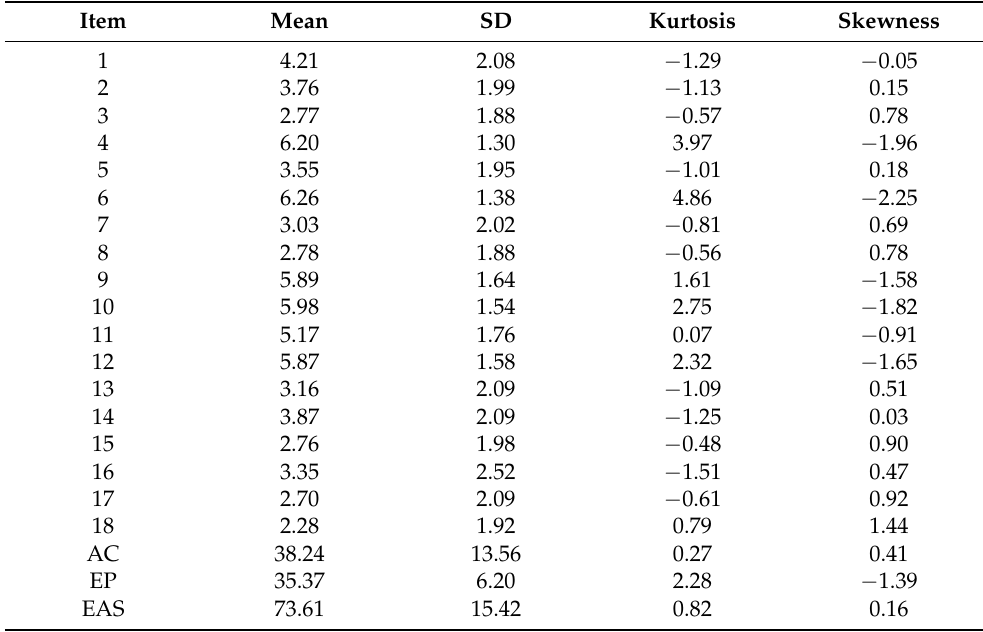
Table 3. Descriptive statistics for each EAS item, EAS subscale, and total scale